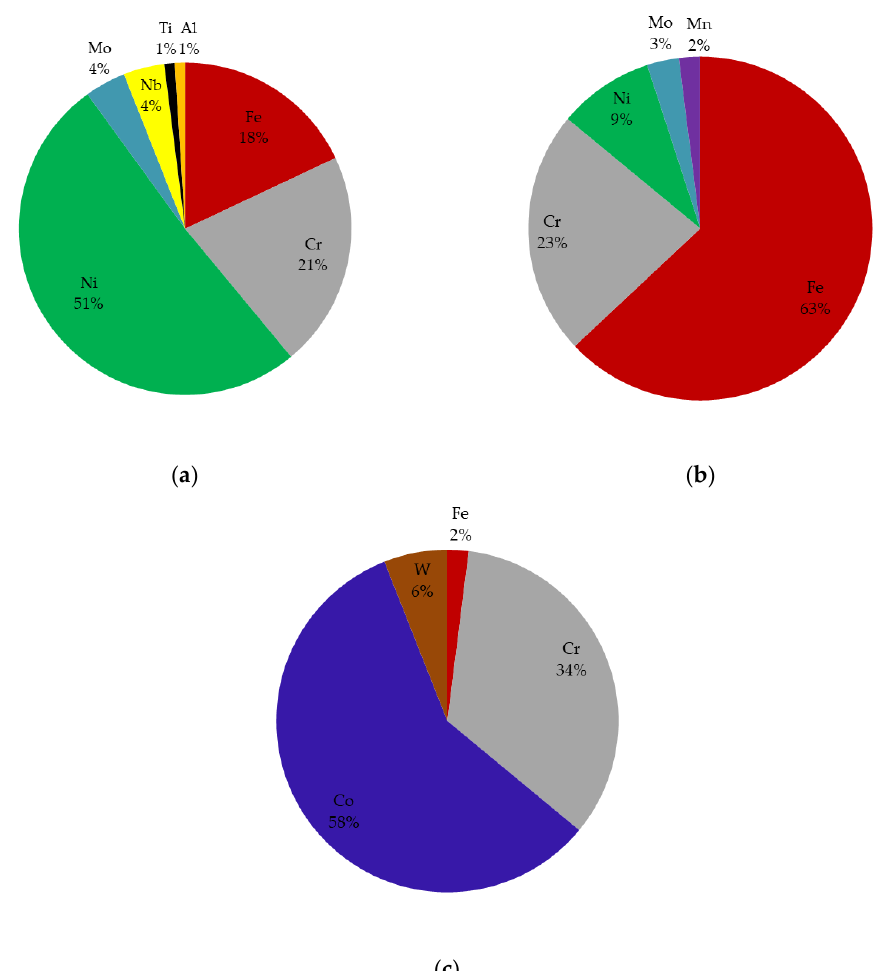
Figure 7. ( a ) SEM image of metal particles; ( b ) X- ray diffractogram of metal particles: α— bcc phases; γ— fcc phases.